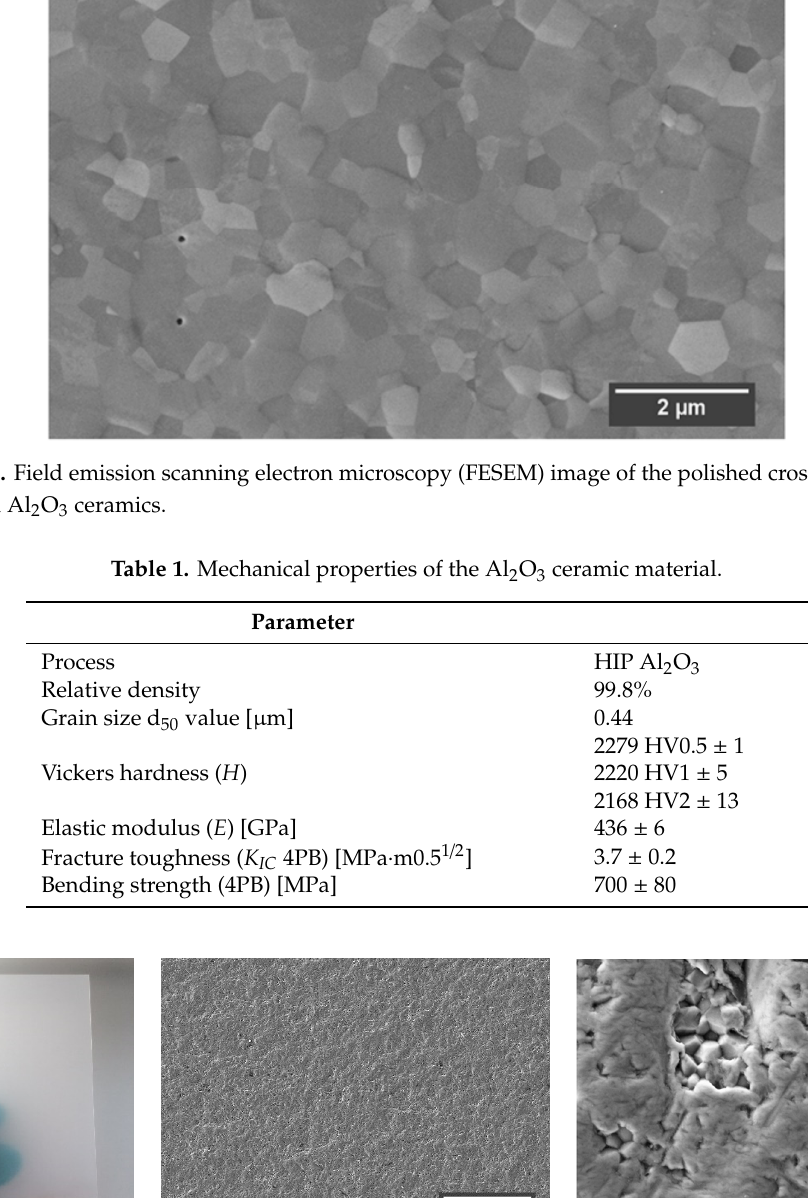
Table 1. Mechanical properties of the Al 2 O 3 ceramic material.